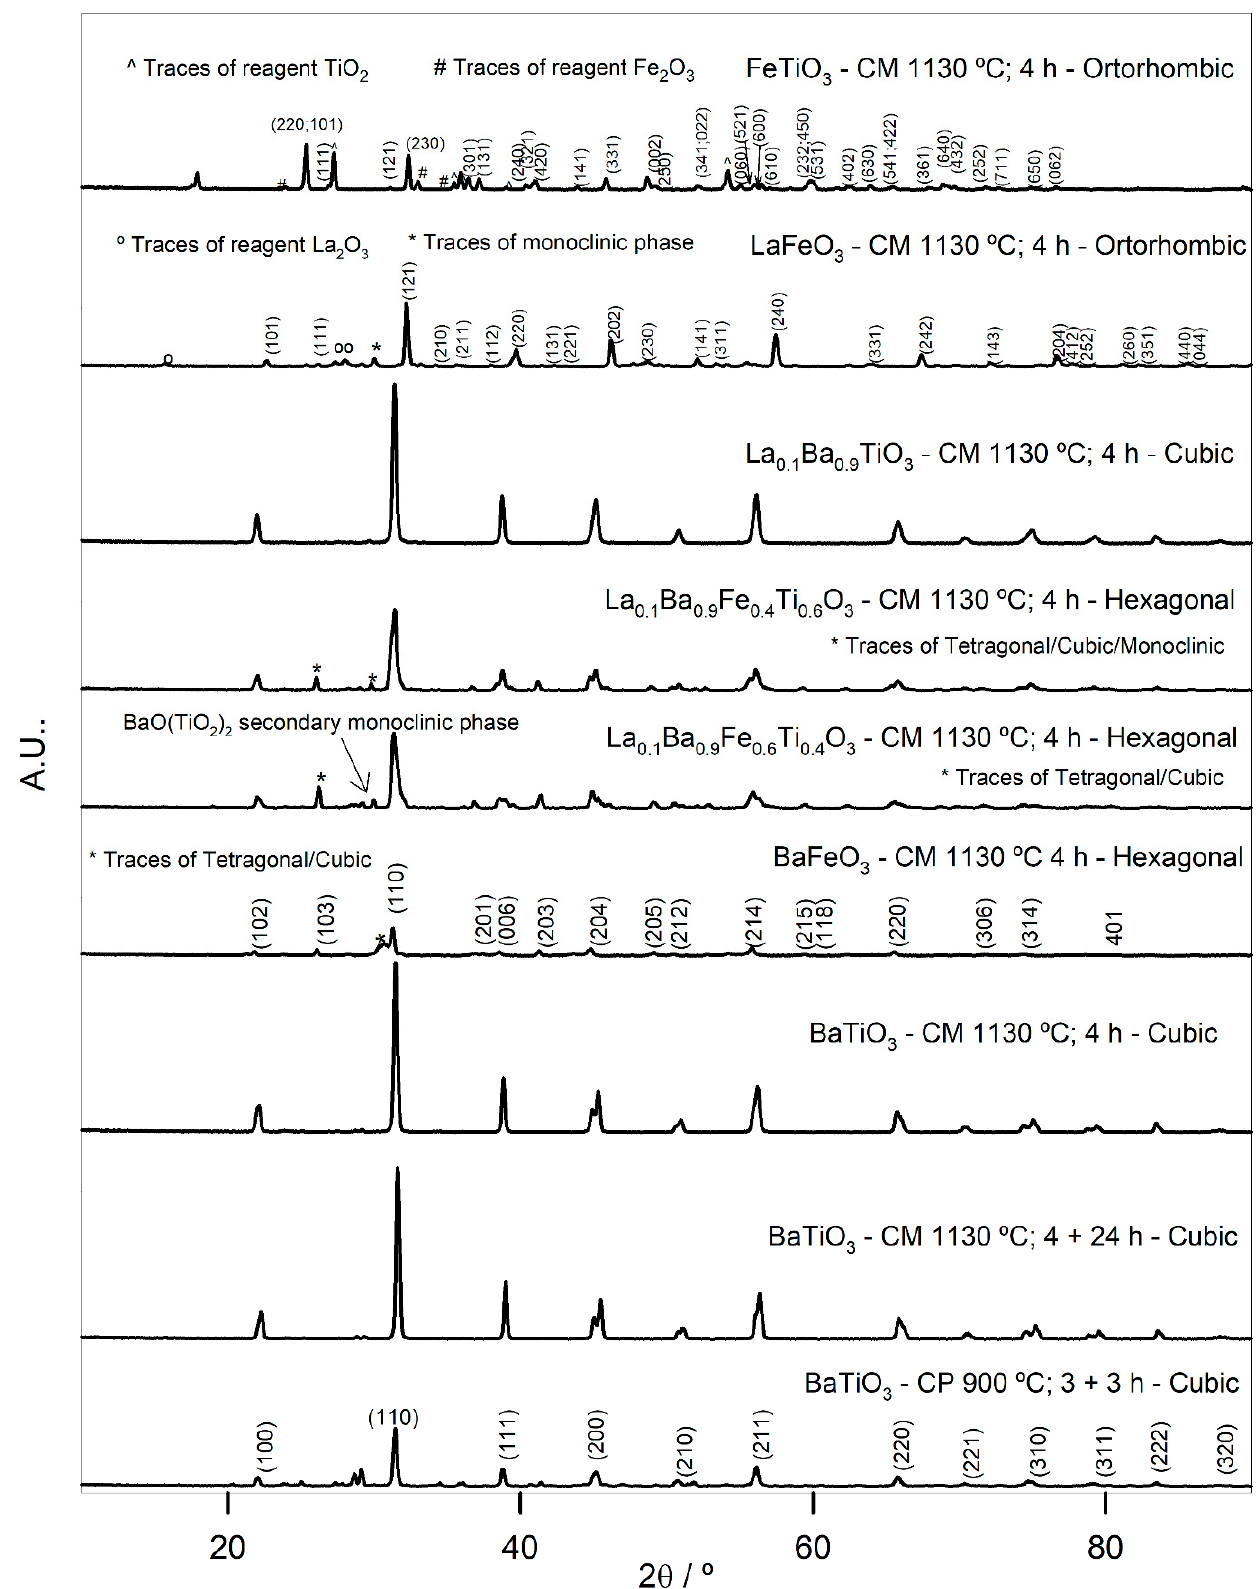
Figure 1. X-Ray diffraction patterns obtained for the different perovskites prepared by different methods.